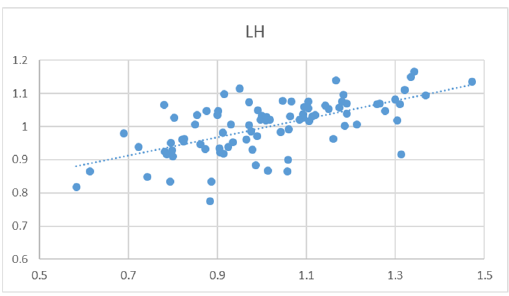
Figure A2. Normalized monthly mean cloud forcing (y-axis) vs. rest hour (x-axis) during 2010–2019 for New Delhi, Kathmandu, and Dhaka.